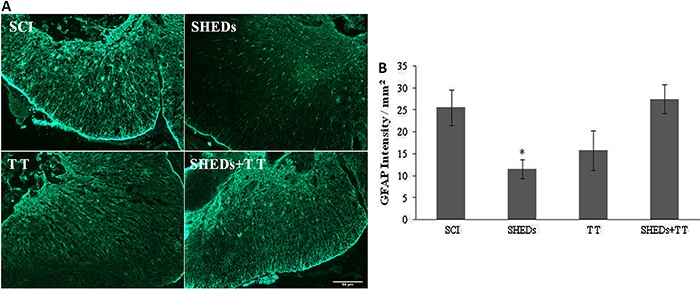
Representative immunostaining of GFAP expression in the epicenter of injured spinal cord, 6 weeks after spinal cord injury (SCI), SCI treated with stem cells from human exfoliated deciduous teeth (SHEDs), SCI treated with treadmill training (TT), and SCI treated with SHEDs and treadmill training (SHEDs+TT) rats (A). Densitometry of GFAP (B). Data are reported as means±SE. *P<0.05, SHEDs group compared to SCI group (one-way ANOVA followed by Tukey's post hoc test). Scale bar = 50 µm.